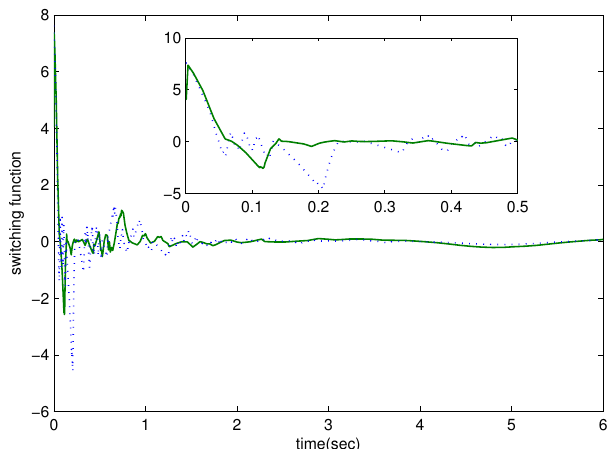
Figure 5. The switching function response curves (the proposed method with solid lines, the memoryless design method with dashed lines).